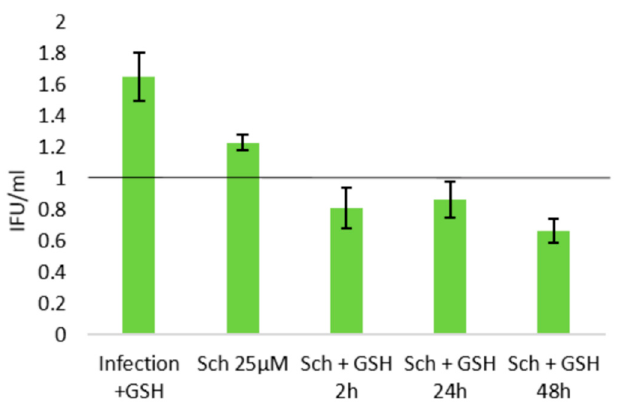
Figure 6. The impact of glutathione supplementation on schisandrin-induced changes in C. pneumoniae elementary body (EB) production. Data are normalized to the non-treated infection control and shown as a mean ± SEM (n = 4). Abbreviations: Sch = schisandrin.